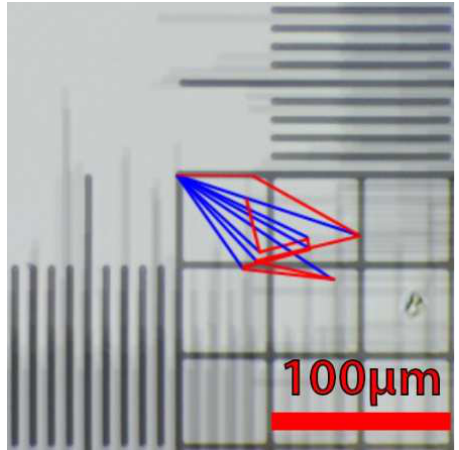
Figure 11. Evaluation of the repeatability of the camera positioning. Ten images have been captured and superimposed after homing and successive repositioning of the camera. The blue lines represent the deviation from the initial position and the red lines represent the deviation from the previous position.